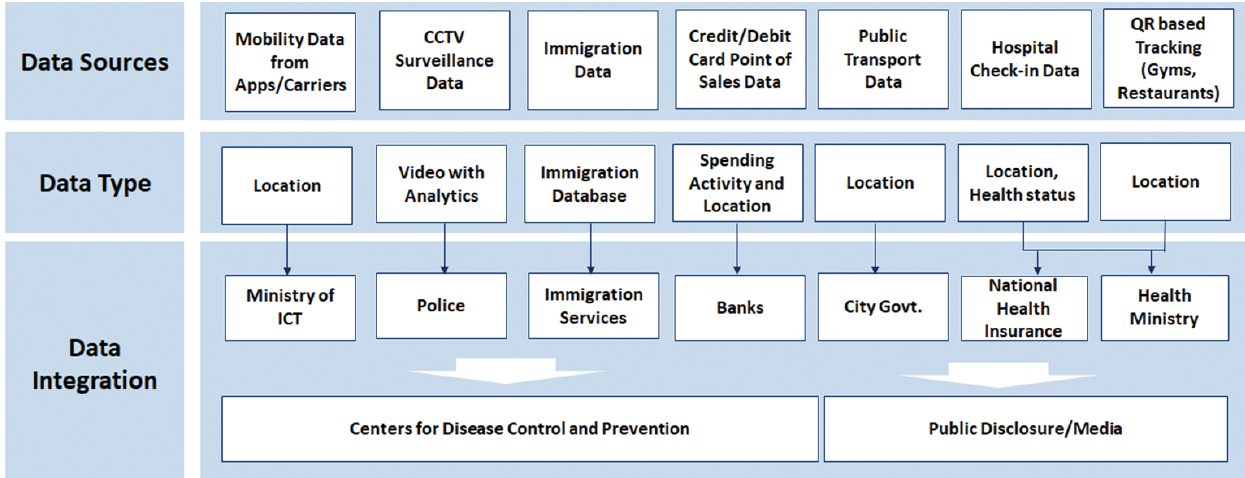
Figure 2. An Example of a Test and Trace IoT